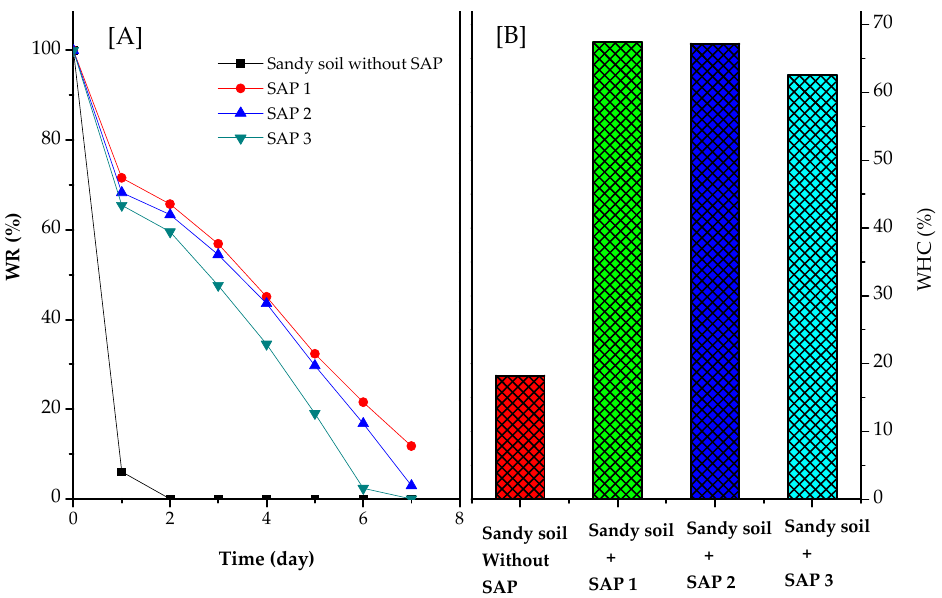
Figure 8. Calculations of ( A ) water holding capacity (WHC) and ( B ) water retention (%) of